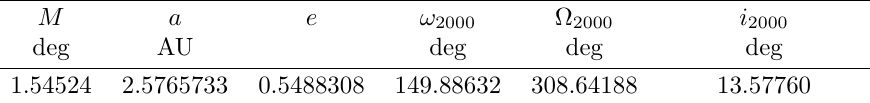
Table 2. Nominal orbit of the asteroid 2010 BT3 from MPO 174050 (epoch 2010 January 4).